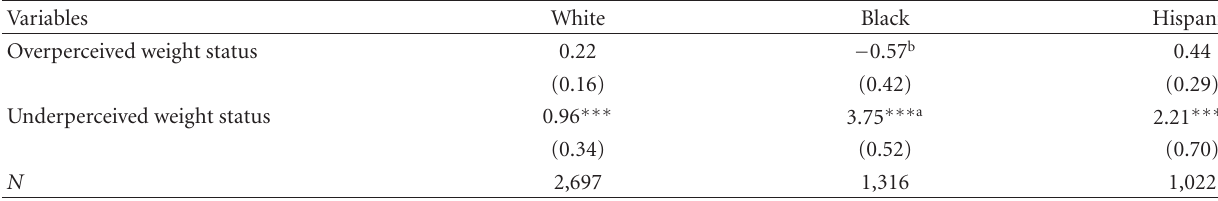
Table 4: Regressions estimates of adolescents body mass index, regression coe ffi cients